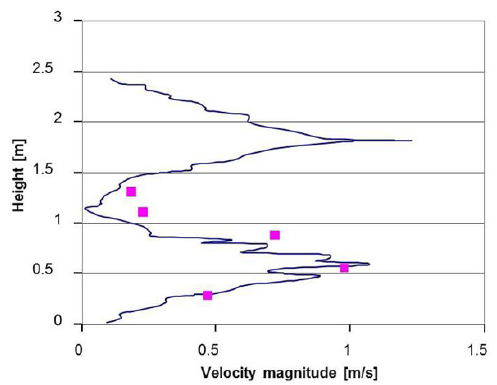
Figure 17. Velocity profile in position AIRV. Measurement data takenatheightsY=0.275m,0.550m,0.875m,1.100m, 1.300 m.